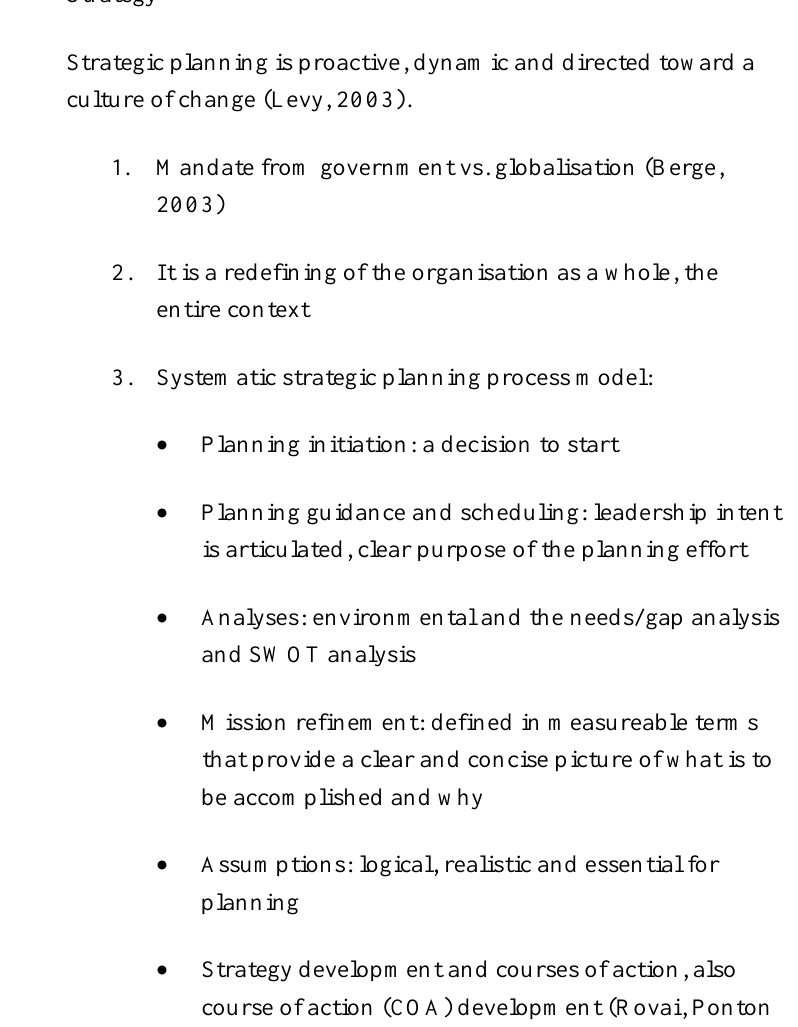
Template for the Study on Access for Success in ODL Planning Code